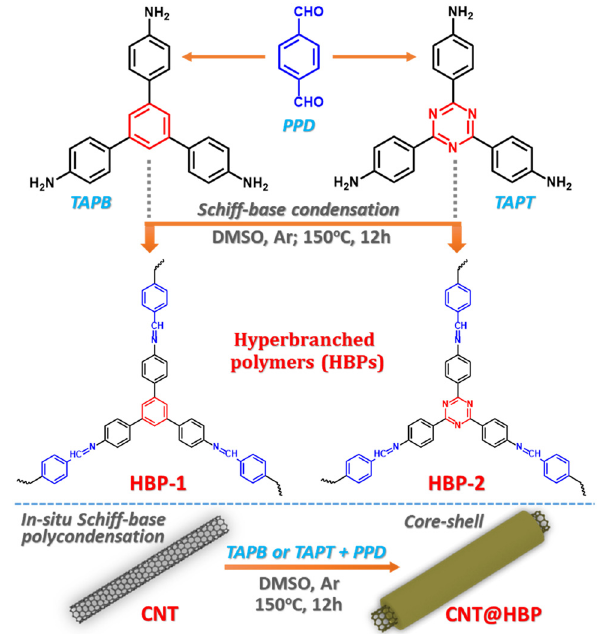
Figure 1: Chemical structures and synthesis routes of hyper - branched polymers ( HBP - 1 and HBP - 2 ) and the composites with CNTs ( CNT@HBP ) by Schi ff - base